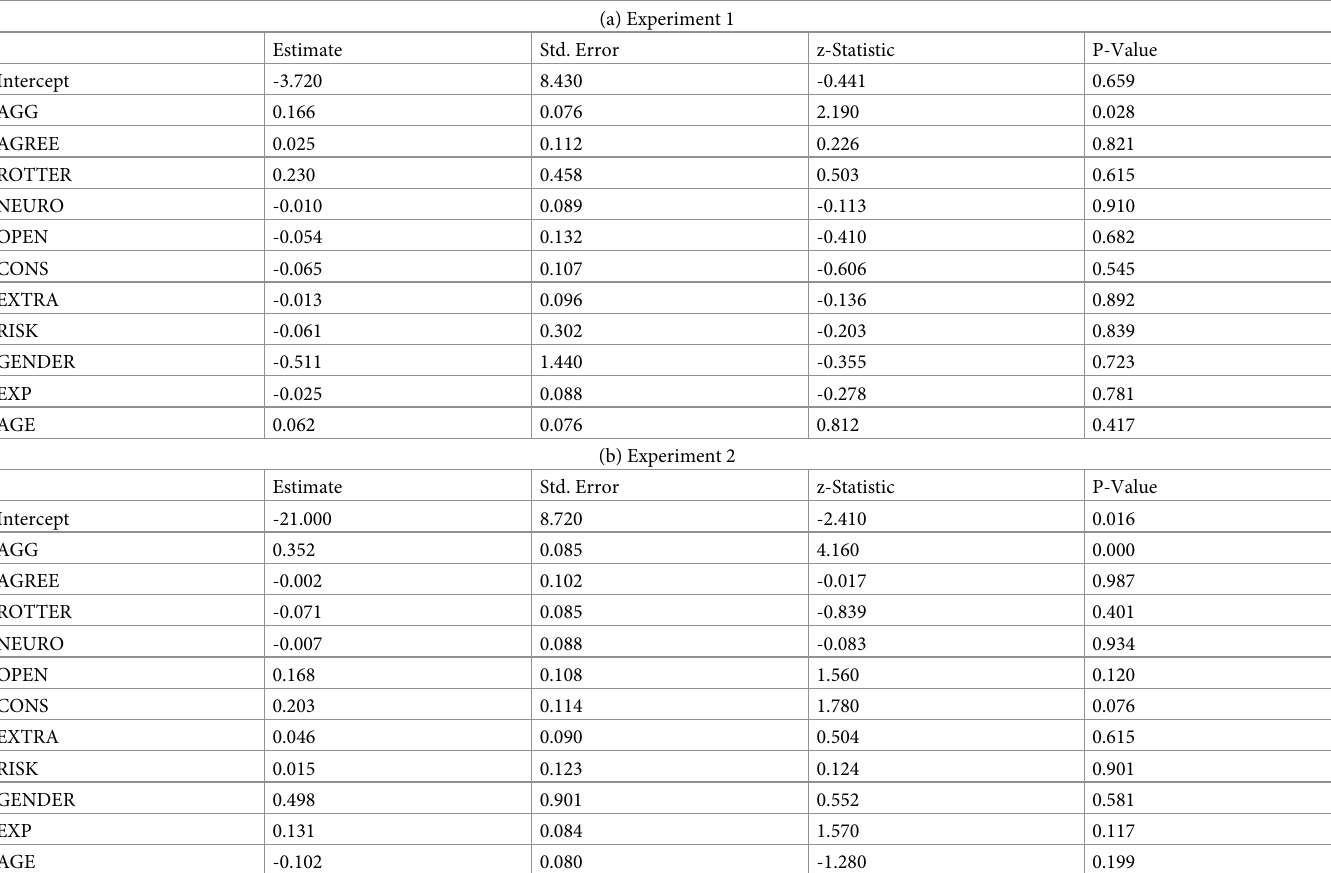
Table 6. Determinants of investing vs. tracking in the baseline treatment. The table presents the results of a multivariate logistic regression in which the dependent vari- able is the invest/track decision and the independent variables are personality, risk preference, and demographic information for the